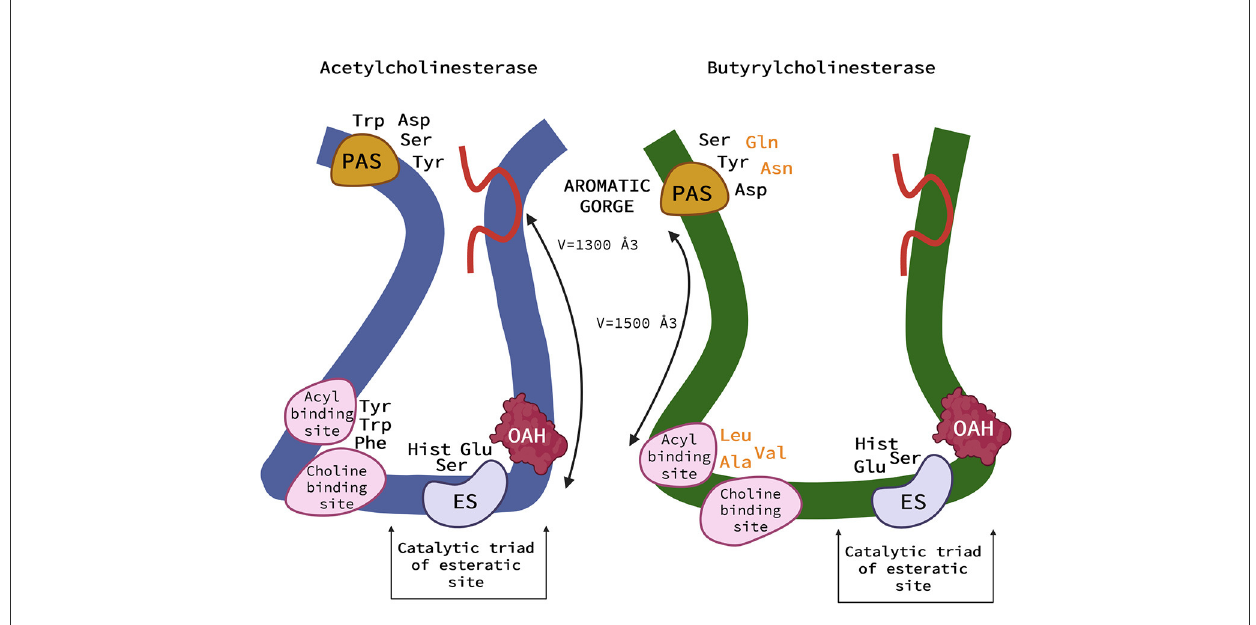
FIGURE2 Schematic representation of the acetylcholinesterase (AChE) (left) and (butyrylcholinesterase) BChE (right) . AChE and BChE differ in the size of the binding pocket, with BChE having an approximate gorge volume of 1,500 Å3 and AChE of 1,300 Å3. Peripheral aromatic site (PAS) is located near the entrance and plays an important role in substrate entry. PAS of AChE contains serine, tyrosine, aspartic acid, and tryptophan, in BChE it is asparagine, aspartic acid, glutamine, serine, and tyrosine. The residues in BChE are more aromatic, resulting in a more negatively charged site. The acyl and choline binding sites are close to the esteratic site and consist of tryptophan, tyrosine, and phenylalanine in human AChE and are replaced by leucocin, alanine, and valine in BChE. The main role of the anionic site is to position the ligand for catalysis. Substitution with more aromatic residues leads to conformational changes that result in a deeper gorge in BChE. This allows BChE to interact with and potentially hydrolyze a much broader range of substrates and inhibitors than AChE. The catalytic triad of the esteratic site is located deep down in the gorge and consists of serine, glutamic acid, and histidine. The oxyanine hole (OAH) is a two- or three-pronged site in BChE. The Ω (omega) loop (red in this Figure) helps the enzyme “breathe”—a process that can help substrates move from the surface to deeper regions. It consists of about 30 amino acid residues (33) (Created with